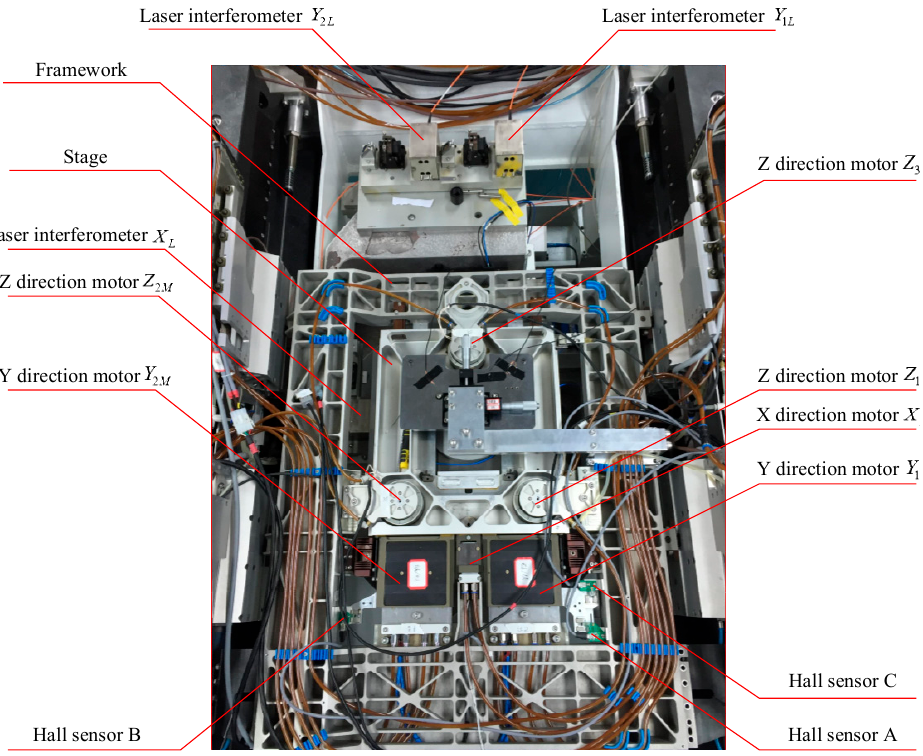
Figure 5. The precision stage.